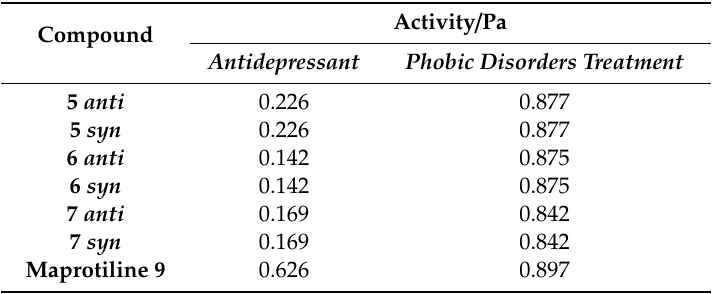
Table 4. Prediction of antidepressant and anti-phobic activities of the compounds (5–7) anti , (5–7) syn, and maprotiline 9.